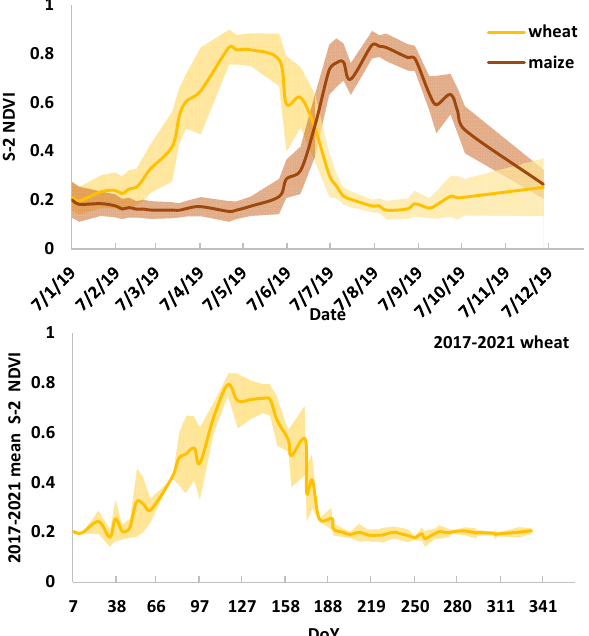
Figure 3. Top panel : NDVI derived from S ‐ 2 data over all the wheat and maize fields of the Riaza district in 2019. The shaded area represents the inter ‐ field variability. Bottom panel : NDVI derived from S ‐ 2 data and averaged over all the winter wheat and barley fields of the Riaza district from 2017 to 2021. The shaded area represents the inter ‐ annual variability. DoY stands for day of the year. Concerning the irrigation practices, both winter and summer crops are irrigated, though with different strategies. Figure 4 shows the temporal series of the irrigation events registered over the wheat and barley (red) and maize (green) fields irrigated 5 to 0 days before the S ‐ 1 passages from 2017 to 2021. The red and green shaded areas represent the corresponding total extent of the irrigated fields. The monthly precipitation rate is also reported in light blue. In general, wheat and barley are mostly irrigated from early April to June and maize from June to September. For maize, irrigation is quasi ‐ continuous, while for winter wheat/barley, the irrigation, in most cases, is supplemental. Moreover, the number of irrigated fields significantly differs from 2017 to 2021. This is due to the largely variable meteorological conditions, which drive the irrigation scheduling. For ex ‐ ample, April 2017 was unusually dry, therefore winter and barley fields were abundantly irrigated, while, on the other extreme, the whole spring of 2018 was very wet and winter crops were sparsely irrigated. This means that the number of irrigated events and irri ‐ gated area, in the case of supplemental irrigation, are extremely variable from year to year and month to month. It may also happen to observe only one event for some wheat/barley fields. Conversely, the number of maize irrigated fields and related irrigated area are more stable per year and month. A quantitative analysis of the temporal trend of irrigation areas will be addressed in a future study.